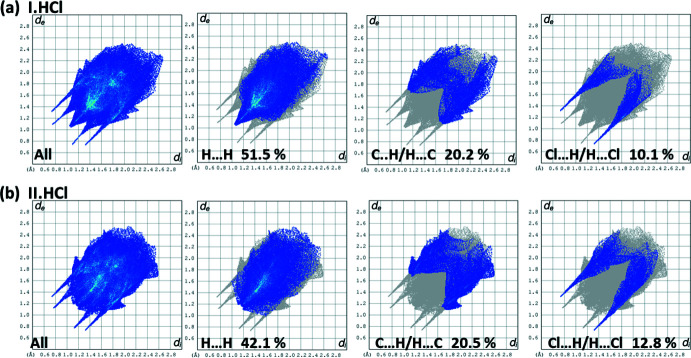
The two-dimensional fingerprint plots for compounds (a) I·HCl and (b) II·HCl, and those delineated into H⋯H, C⋯H/H⋯C, and Cl⋯H/H⋯Cl contacts.